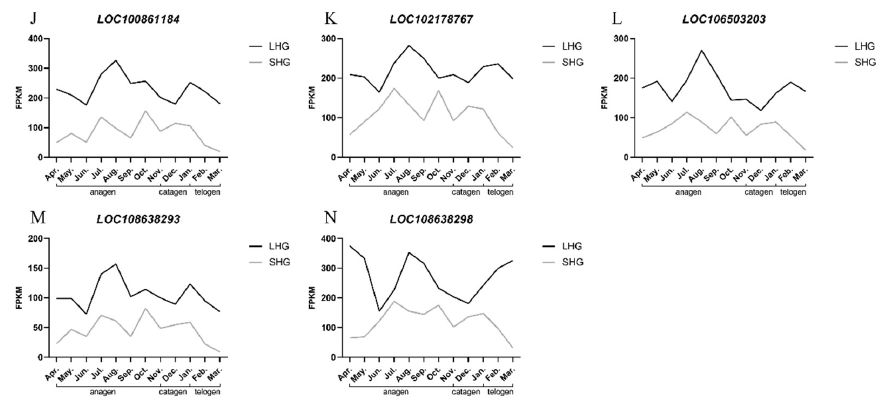
Figure 6. Gene expression trends of the candidate genes. ( A – N ) Abscissa is month, anagen (April to November), catagen (December to January), and telogen (February to March); ordinate is the FPKM. The total RNA was extracted from 42 skin samples, and the quality of the total RNA